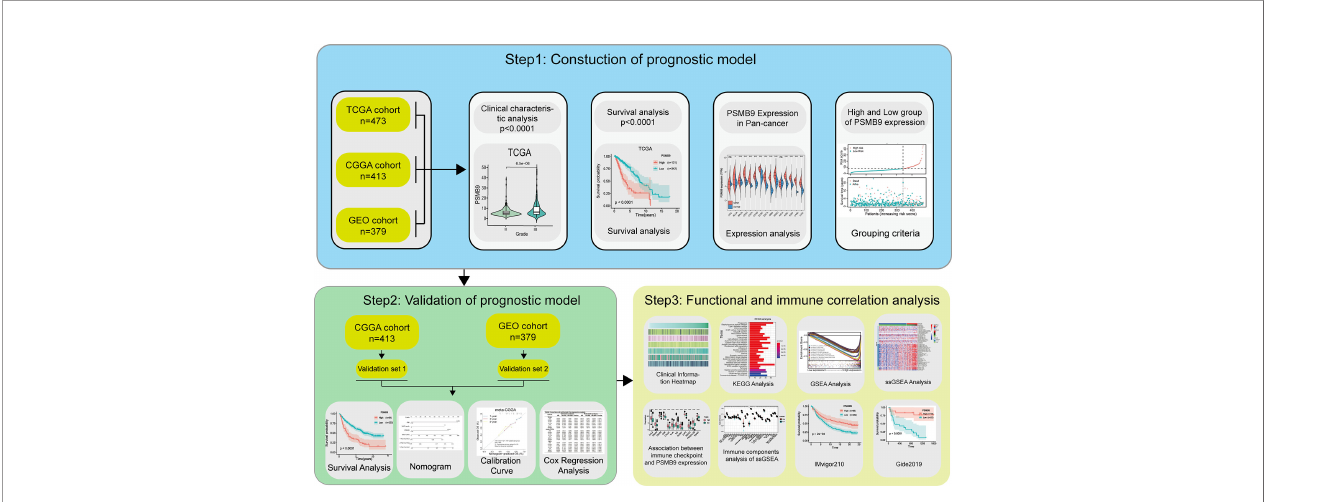
FIGURE 1 | Flow chart of this study. Step1: The sequencing data and clinical information data of LGG patients were downloaded from the TCGA, CGGA and GEO databases respectively, and the PSMB9 gene expression was extracted and matched with the clinical information for analysis of survival and expression differences. Step2: Nomogram model was constructed and its predictive stability was tested for the prognose in LGG patients. Step3: GO, KEGG, and GSEA analysis were performed to predict the function of PSMB9. Immune-related analyses including ssGSEA, CIBERSORT and ESTIMATE were performed to verify the correlation of PSMB9 with the immune environment and its potential in immunotherapy was identi fi ed in two independent immunotherapy cohorts(IMvigor210 and